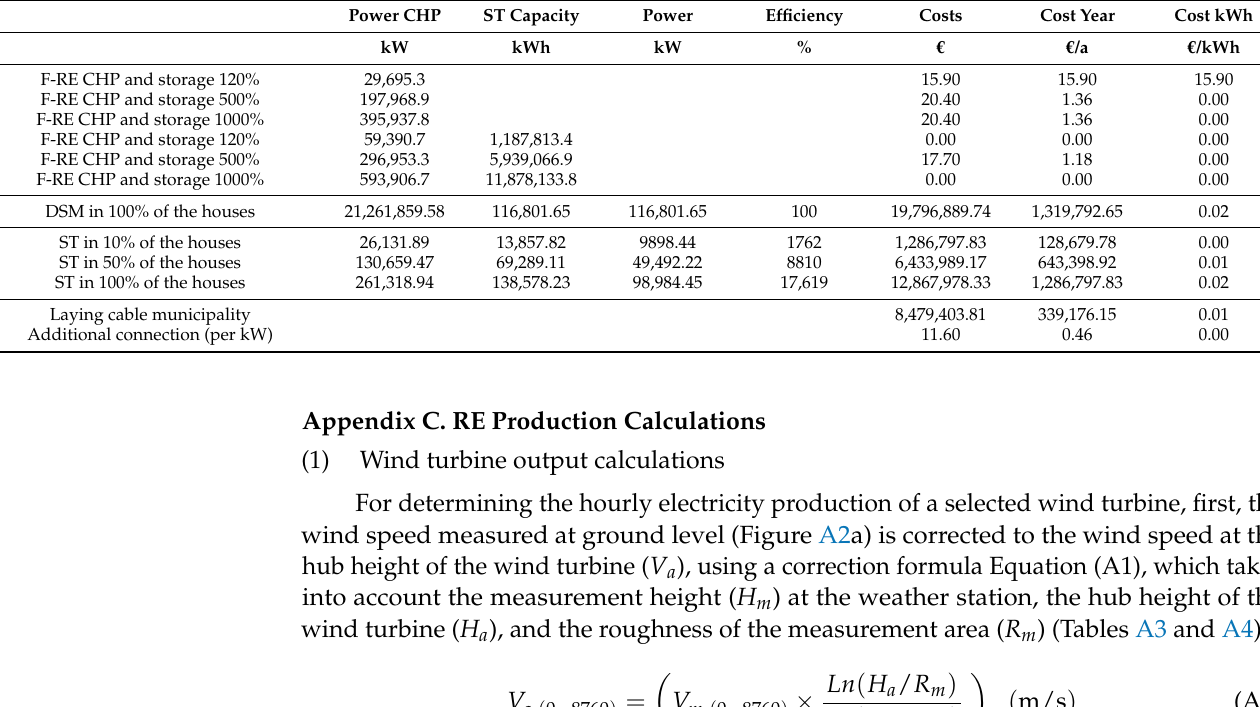
Table A4. Scenario settings for improved local balancing options with expansion capacity AD installation.